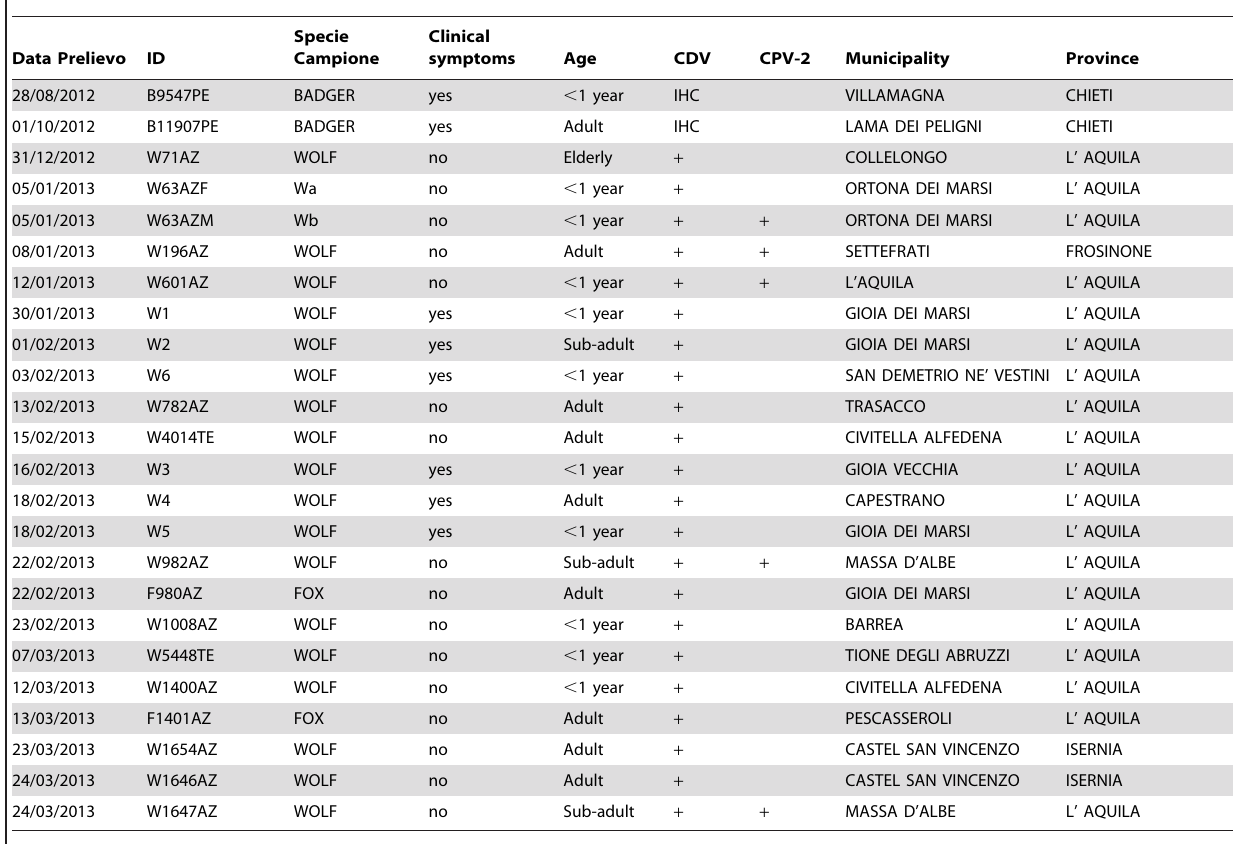
Table 1. Data on wild animals infected with CDV and detected by